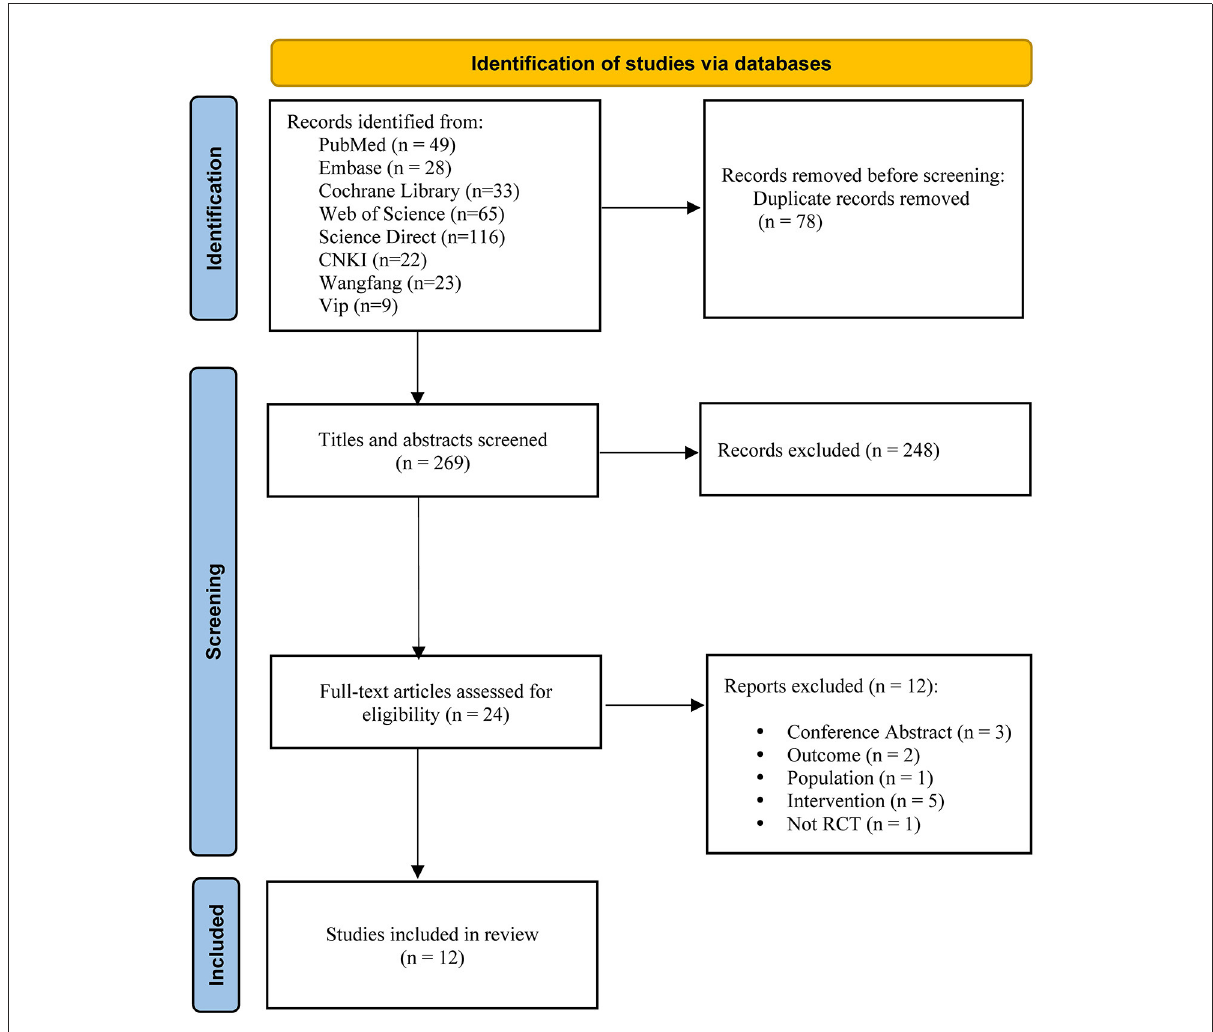
FIGURE1 Flow diagram of the search process and study